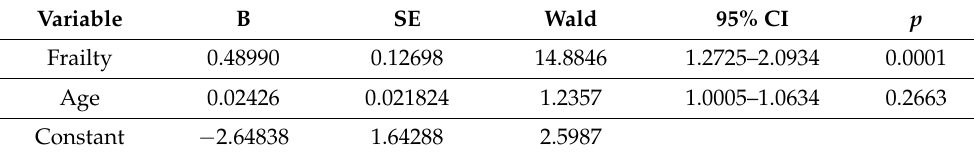
Table 3. Detailed results of logistic regression—male subgroup.